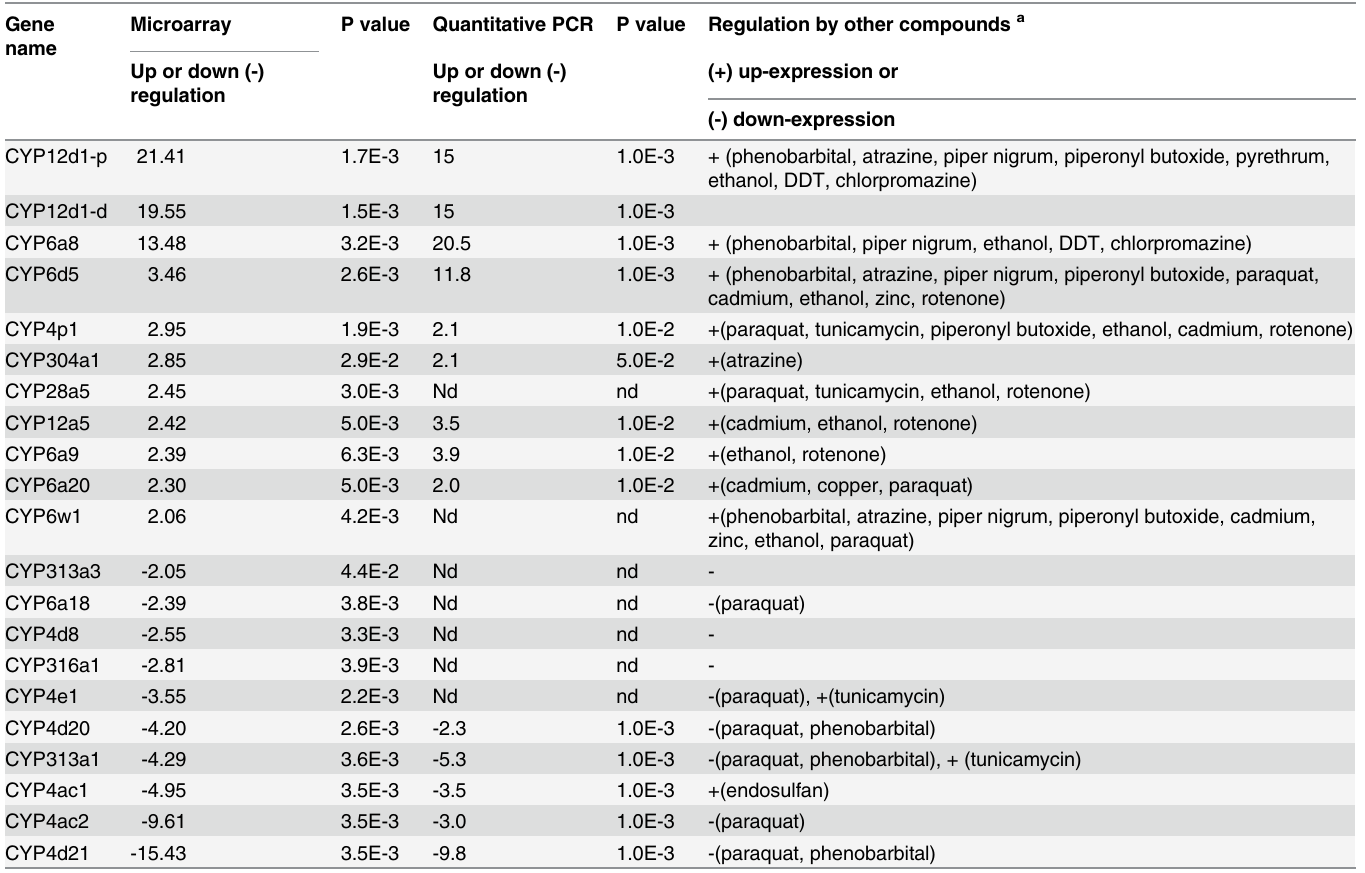
Table 1. Expression of CYP genes in Drosophila melanogaster after caffeine exposure. Gene